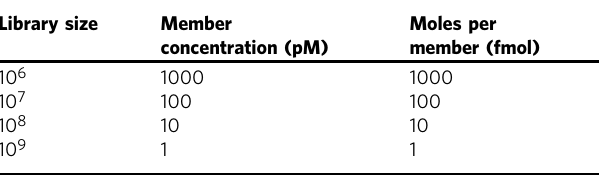
Table 1 Mixtures of up to 10 9 peptides contain suf fi cient material for MS-based